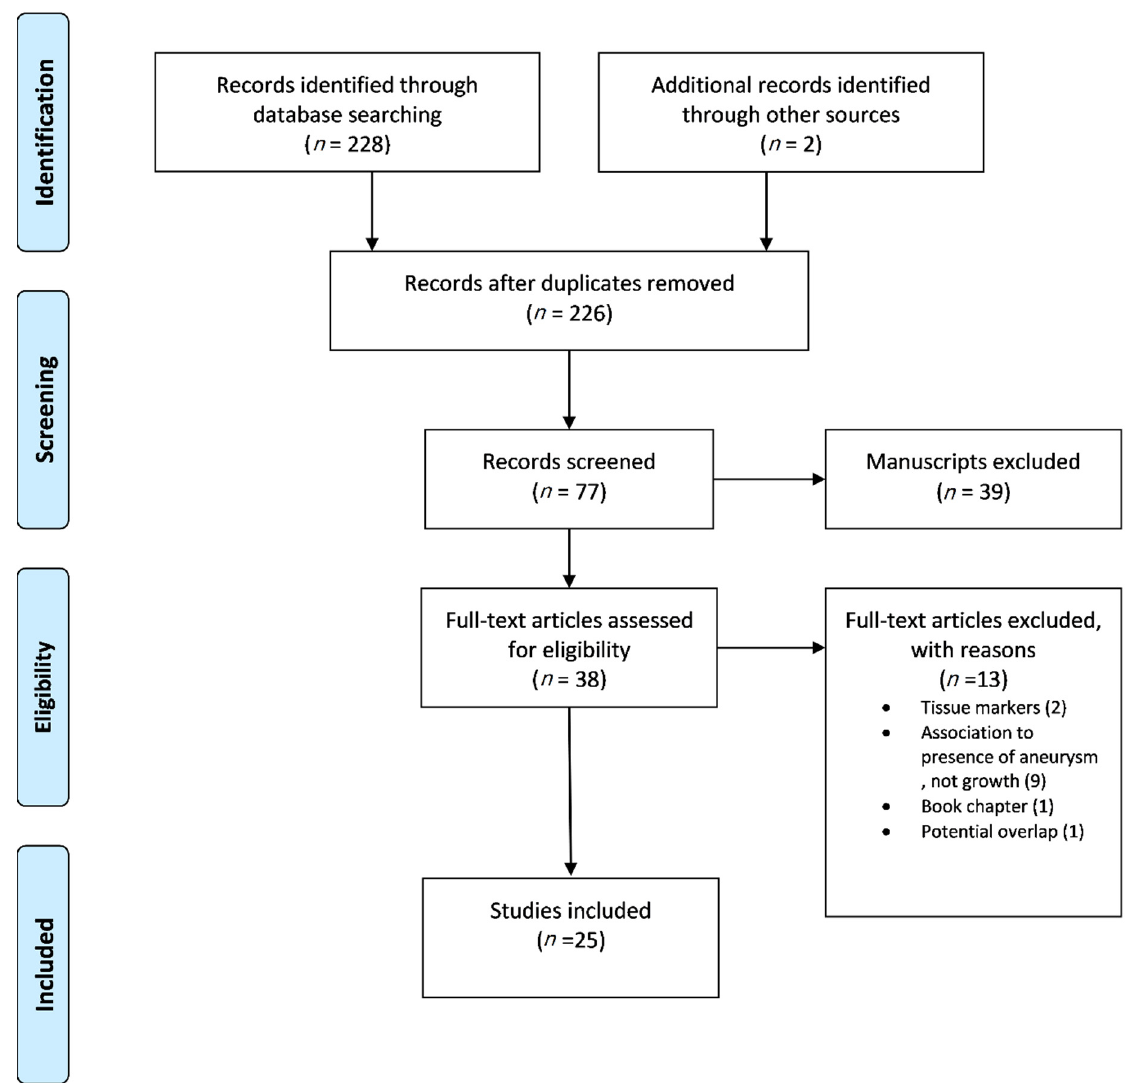
Figure 1. The flow chart of the selection process according to PRISMA statement.